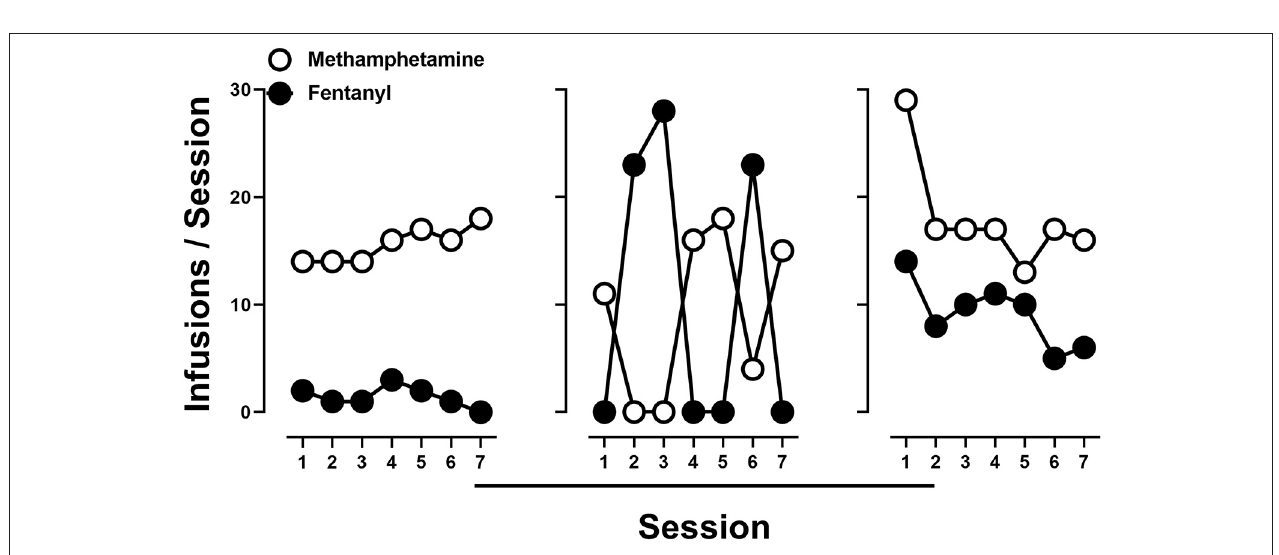
FIGURE 3 | Number of infusions of 0.1 mg/kg/infusion of methamphetamine (open circles) and 0.0032 mg/kg/infusion of fentanyl (filled circles) when methamphetamine and fentanyl were concurrently available in representative rats demonstrating different patterns of drug intake.